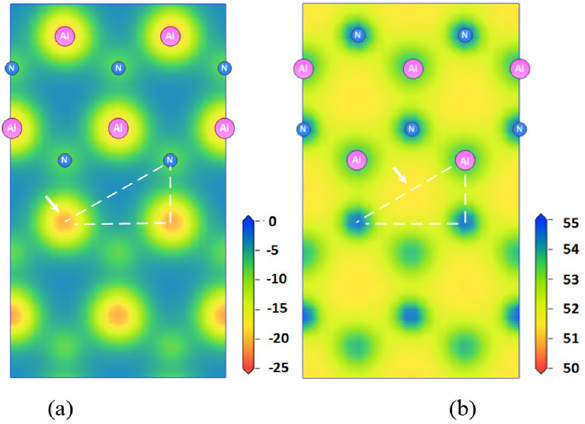
Figure 4. Contour plots of the PES for the AlCH 3 molecule on the ( a ) AlN (0001) surface and ( b ) AlN (000 1 ) surface, the unit is eV.